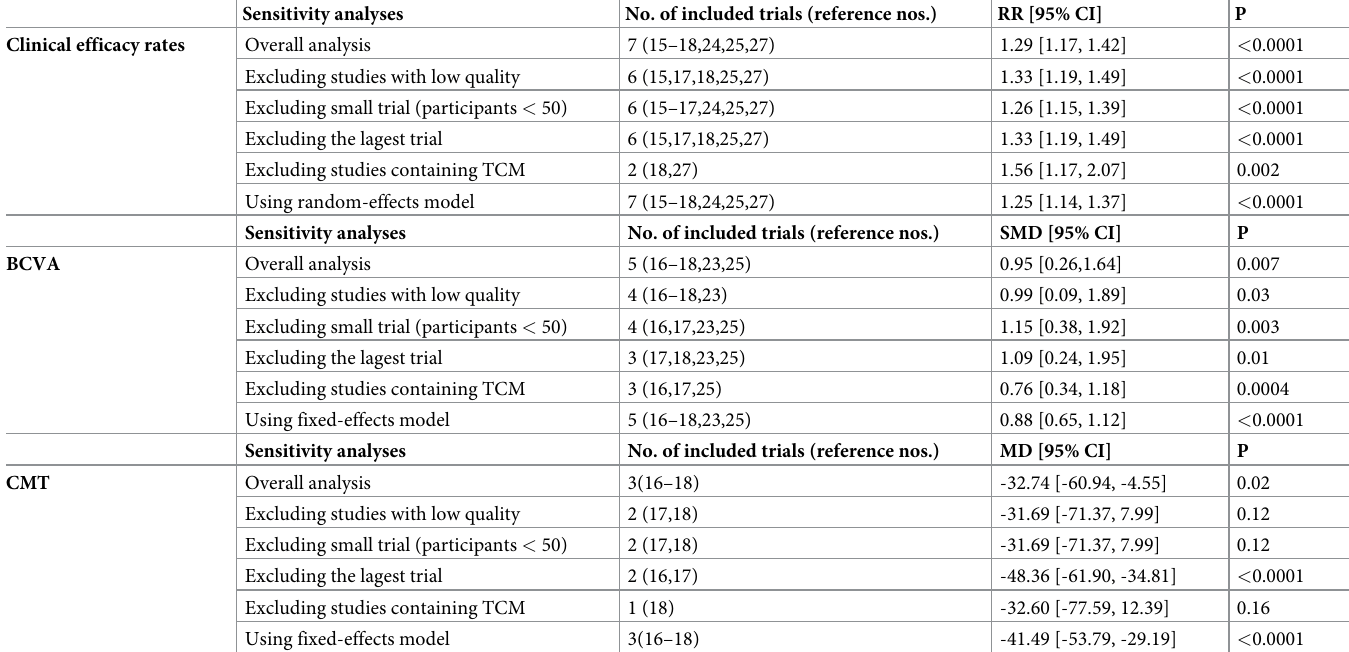
Table 4. Sensitivity analyses.